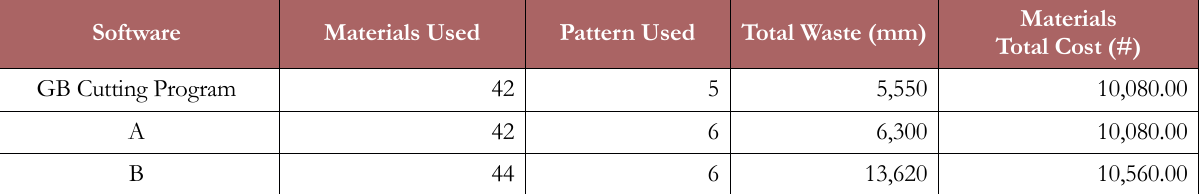
Table 13. Number of materials, pattern used, total waste and cost by each program